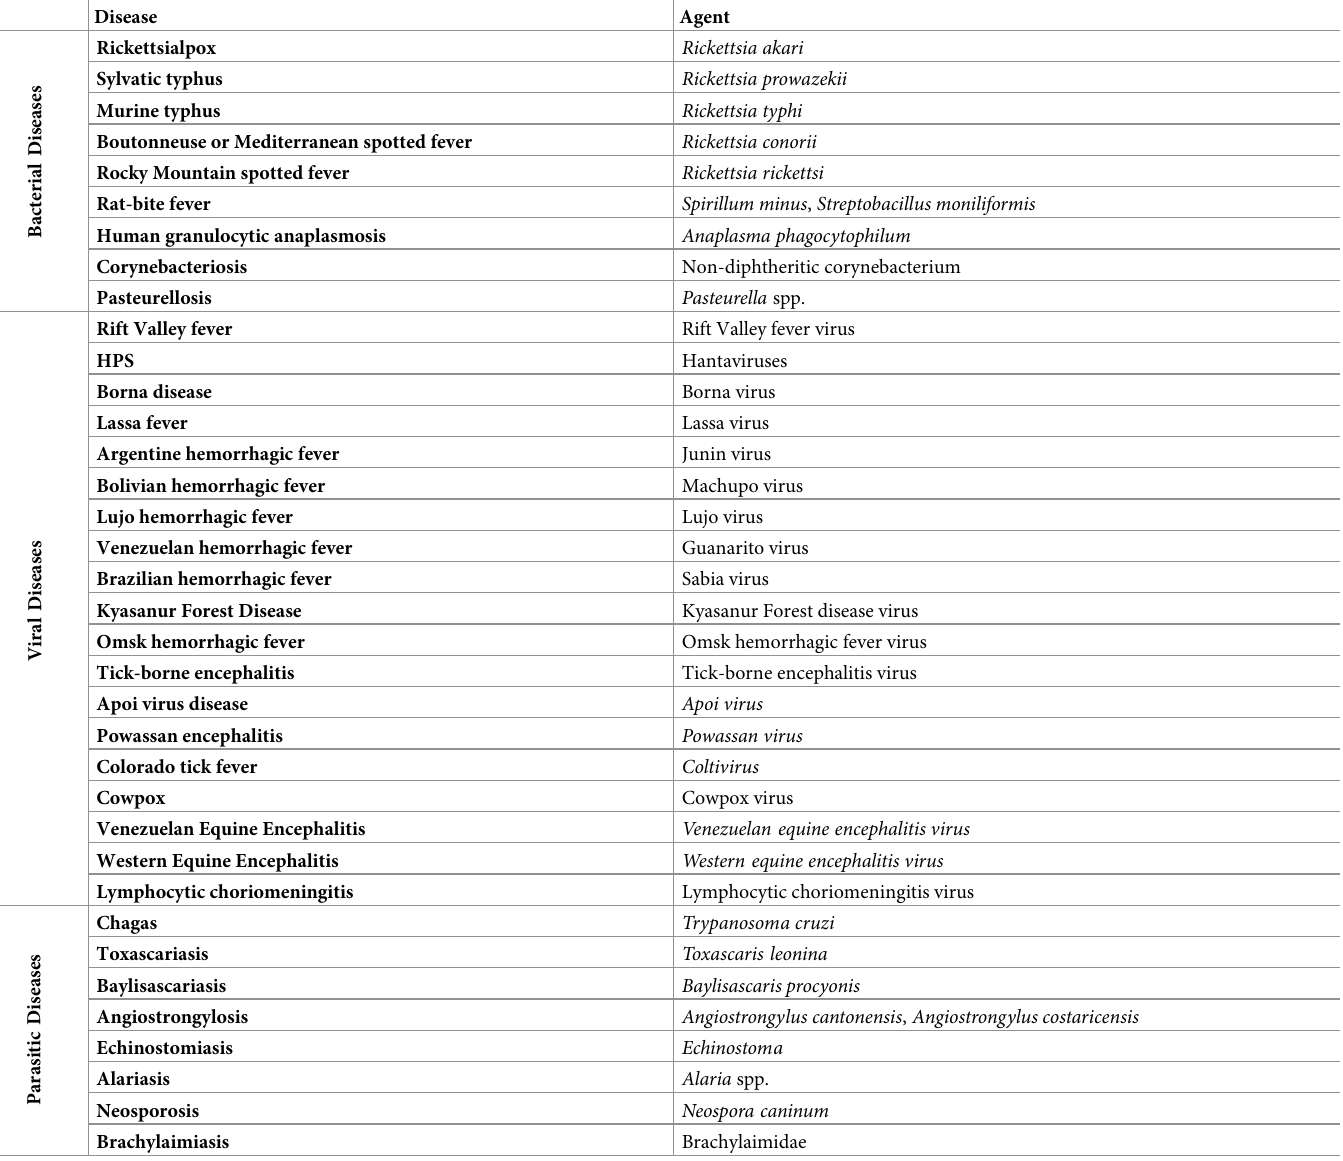
Table 4. Rodent- borne diseases not yet reported in Iran.